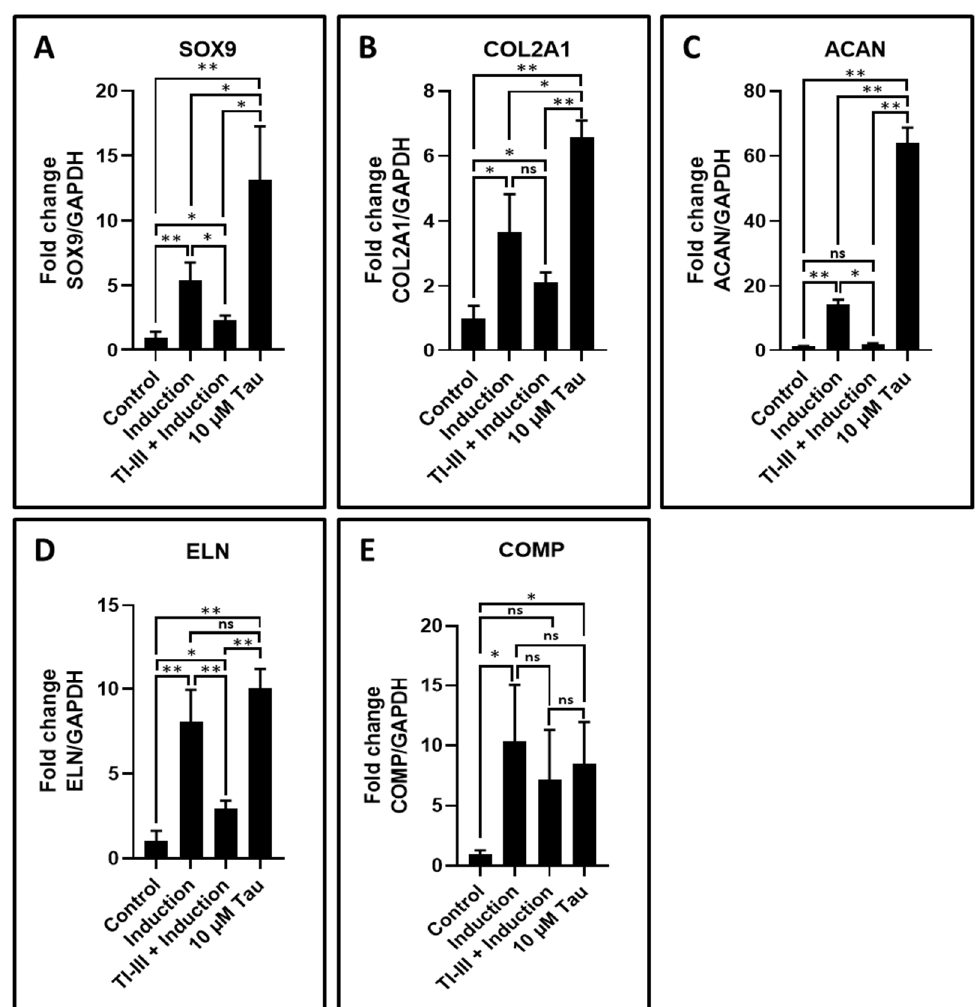
Figure 5. Chondrogenic differentiation of DPSCs and the analysis of chondrogenesis related gene expression by quantitative RT-qPCR. ( A – E ) Comparative gene expression analysis of chondrogenesis-related genes SOX9, COL2A1, ACAN, ELN, and COMP in chondrogenesis induced DPSCs with and without treatment with telomerase inhibitor and DPSCs treated with taurine alone. ns: not significant, * p < 0.05, ** p < 0.01. Induction: chondrogenic differentiation, Tau: taurine, TI-III: telomerase Inhibitor III, SOX9: SRY-box transcription factor 9, COL2A1: collagen, type II, alpha 1, ACAN: aggrecan, ELN: elastin, COMP: cartilage oligomeric matrix